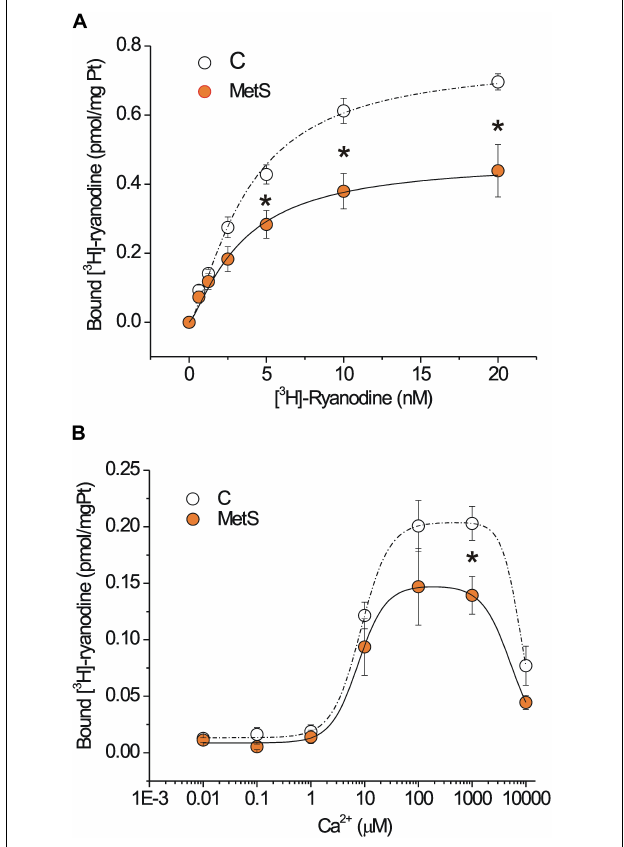
FIGURE 4 | Functional ryanodine receptors are decreased and showed rapid Ca 2 + -induced inactivation in MetS hearts. Saturation binding curve with [ 3 H]-ryanodine. (A) Aliquots of 50 µ g of protein from microsomes (SR-enriched fraction) from control ( N = 6) and MetS ( N = 5) hearts were incubated with [ 3 H]-ryanodine (concentration range of 0.625–20 nM) in incubation medium (containing in mM: 1000 KCl, 0.1 CaCl 2 20 HEPES, pH 7.2) for 90 min at 37 ◦ C. (B) Specific Ca 2 + -dependent [ 3 H]-ryanodine binding curves of SR-enriched fractions from control ( open symbols; N = 9) and MetS ( orange symbols ; N = 6) hearts. Microsomes were incubated with 7 nM [ 3 H]-ryanodine and the indicated [Ca 2 + ] i at 37 ◦ C for 90 min. Values have been normalized and fitted to a modified version of the equation B = B max ([Ca 2 + ] na /([Ca 2 + ] na + K ana ))(1–[Ca 2 + ] ni /([Ca 2 + ] ni + K ini ))+ C . Non-specific [ 3 H]-ryanodine binding was determined in the presence of 20 µ M ryanodine and subtracted from all reported values. Open symbols , control; orange symbols , MetS; dashed line indicates the fitting curve for control and dark solid line the fitting curve for MetS microsomes. ∗ P < 0.05 with respect to corresponding control